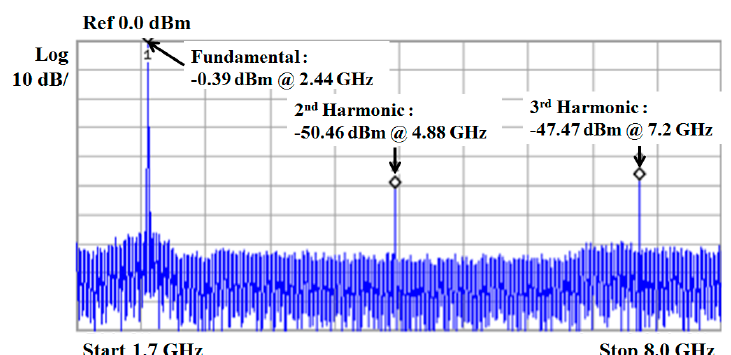
Figure 28. The measured output spectrum of TX.